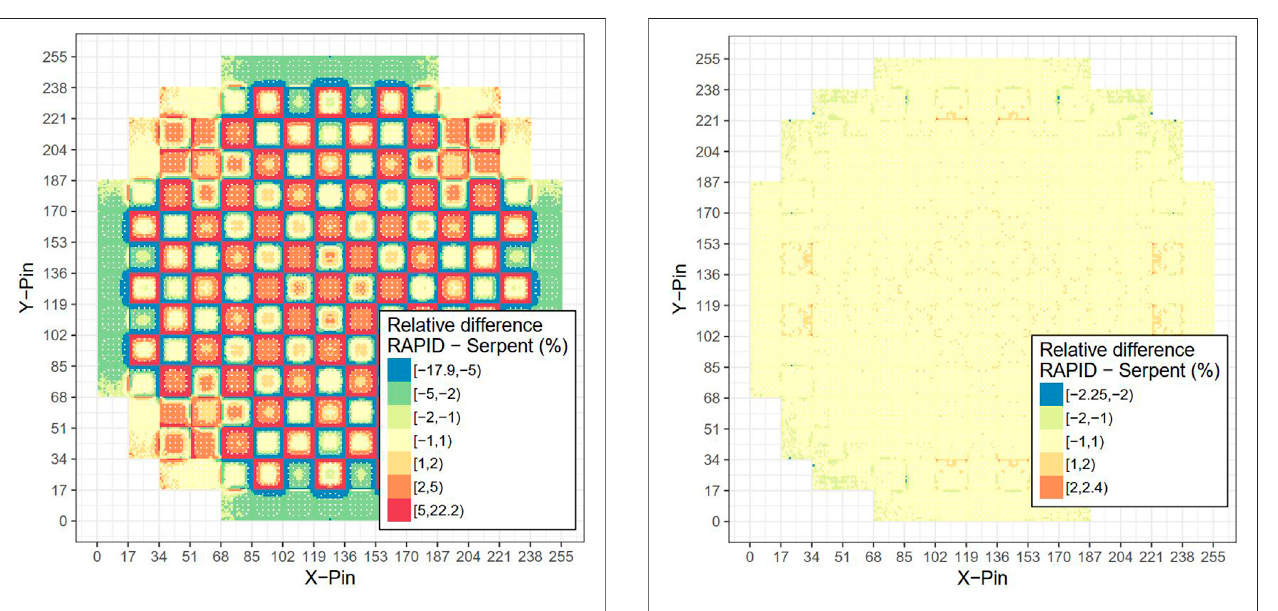
Frontiers in Energy Research |